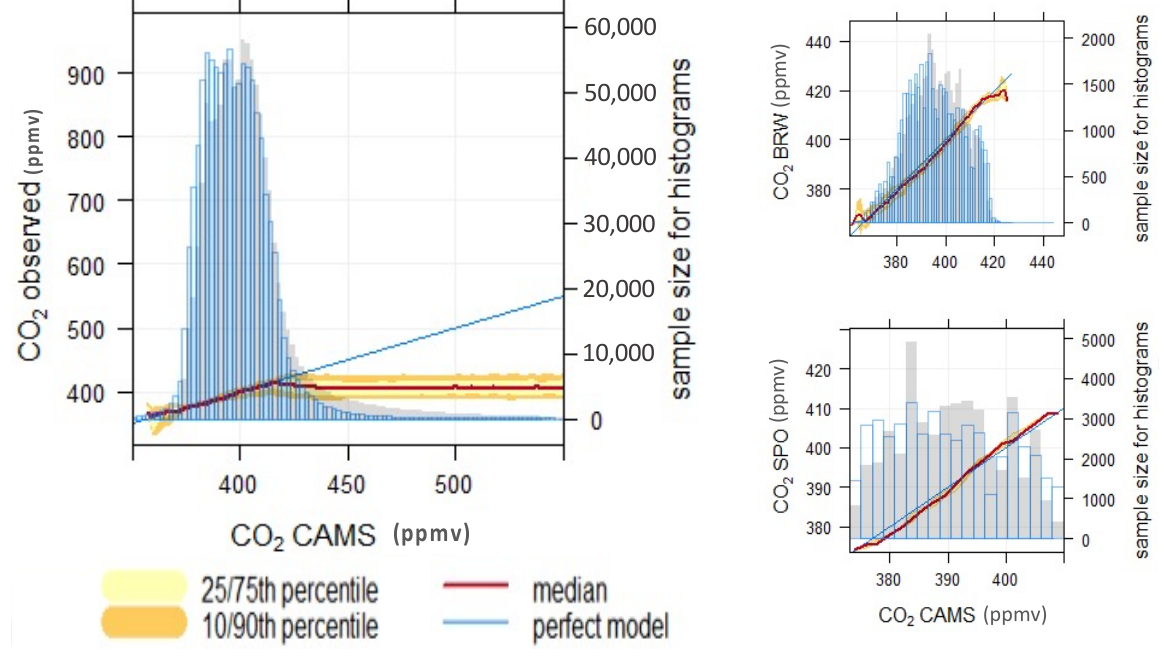
Figure 3. The conditional quantile regression plot shows the comparison between CAMS reanalysis and observation. The observations are split up into bins according to the corresponding CAMS value. On the left, the conditional quantiles of CAMS are displayed again worldwide ground-based observations, which include the data from all stations considered in this study. On the right, the regression specimen for Barrow in Alaska (top right) and South Pole (bottom right) are shown. The median prediction line together with the 25/75th and 10/90th quantile values are plotted together with a line showing a “perfect model”. Also presented is a histogram of CAMS values (shaded grey) and a histogram of observed values (shown as a blue line).